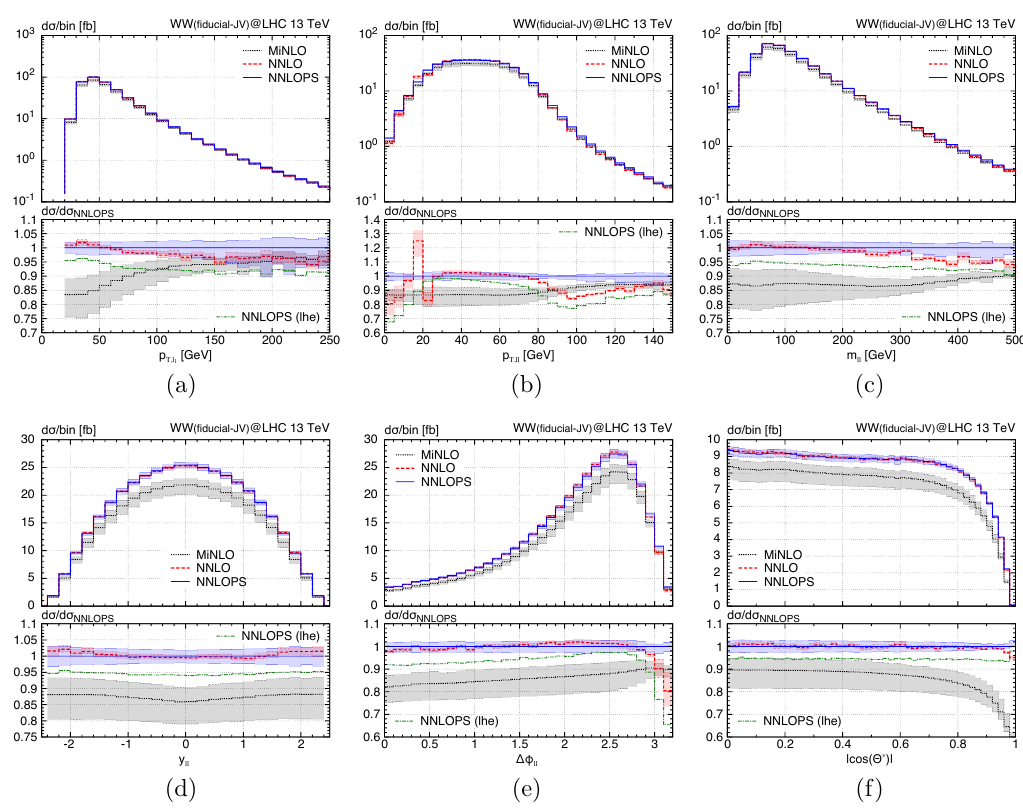
Figure 10 . Same as (cid:12)gure 7, but for various distributions in the (cid:12)ducial phase space measured in the 8 TeV analysis by ATLAS [6]: (a) transverse momentum of the leading lepton p transverse momentum p , (c) invariant mass m and (d) rapidity of the dilepton pair, (d) T;‘‘ ‘ (cid:0) ‘ + azimuthal lepton separation (cid:1) (cid:30) , and (e) j cos( (cid:18) ? ) j de(cid:12)ned in eq. ‘‘